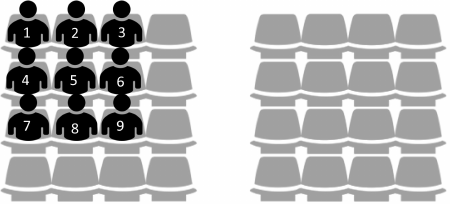
Figure 8. Location distribution of each WBASN in the performance-evaluation-over-time.